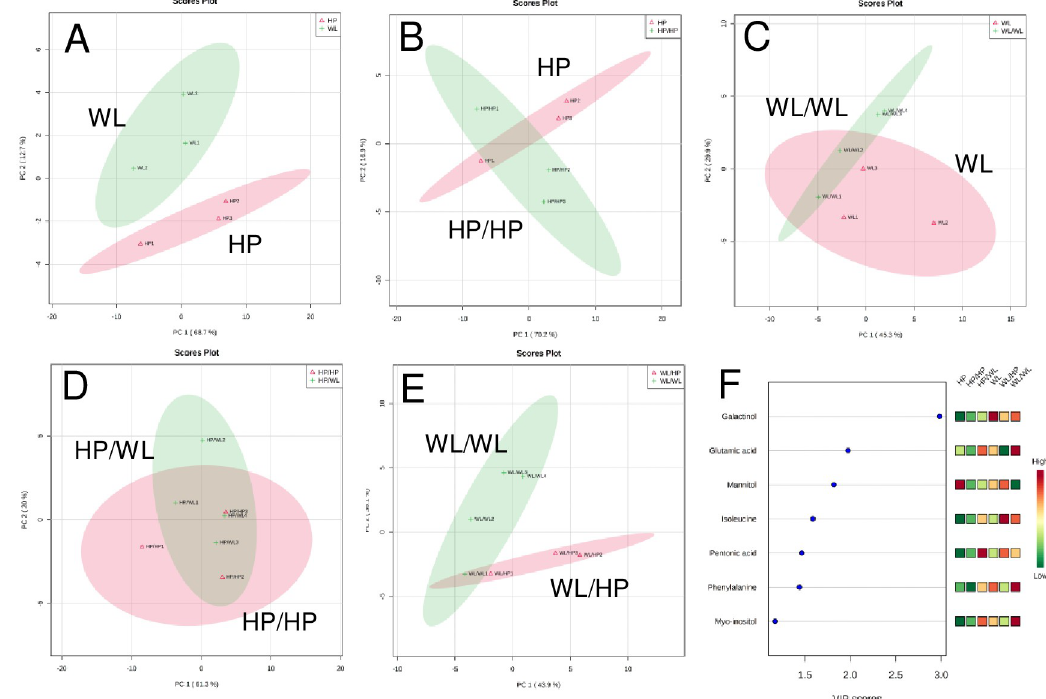
Fig 3. PCA and VIP plots from PLS-DA showing the metabolite differences in the source leaves of non-grafted (A), homo-grafted (B and C) and hetero-grafted (D and E) plants. The VIP plots (F) indicate the major differences between each category. In each plot, the 95% confidence regions are displayed. The leaves were collected six weeks after grafting at four hours after sunrise. The data were obtained from two consecutive experiments with 3–4 groups of samples. Each group contained 3 leaf disks 1 cm in diameter cut from the middle of assimilating leaves of 3 individual plants. The labels are as in Fig